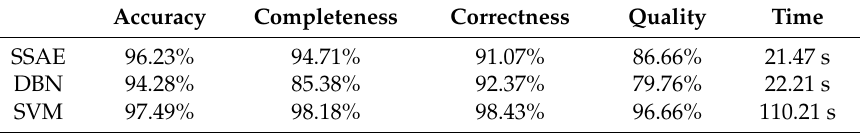
Table 7. Different methods of extraction results of Area 34.